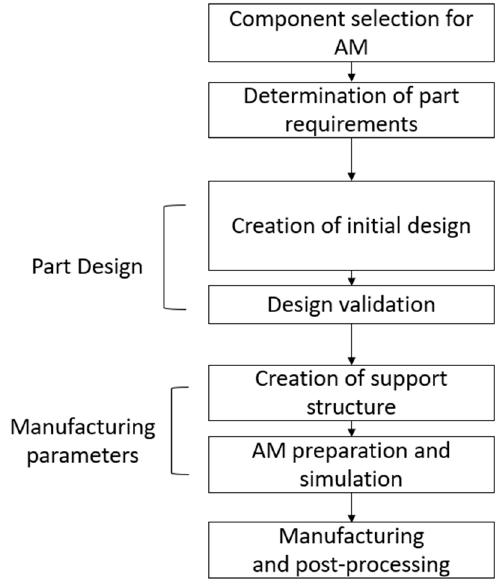
Figure 6. Design activities that form the art design process for AM.